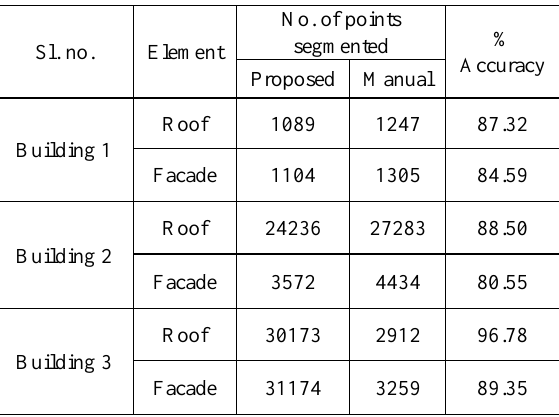
Table 2: Accuracy